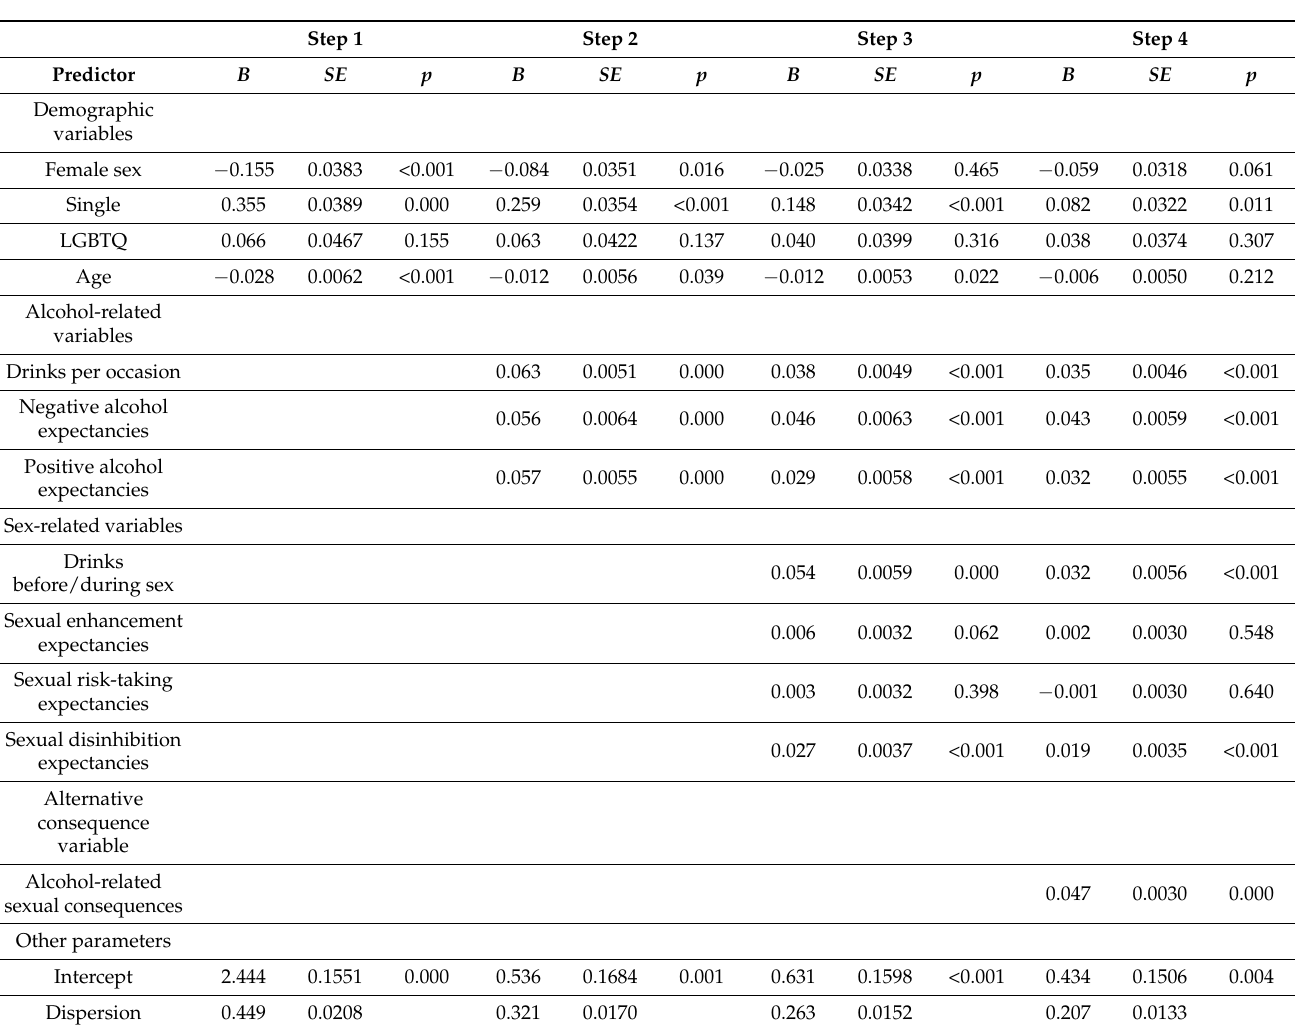
Table 4. Results of negative binomial regression models predicting alcohol